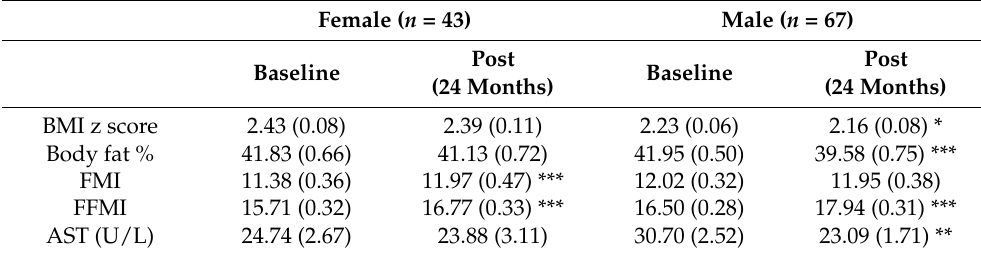
Table 3. Changes in BMI z score, body composition, and cardiometabolic risk markers